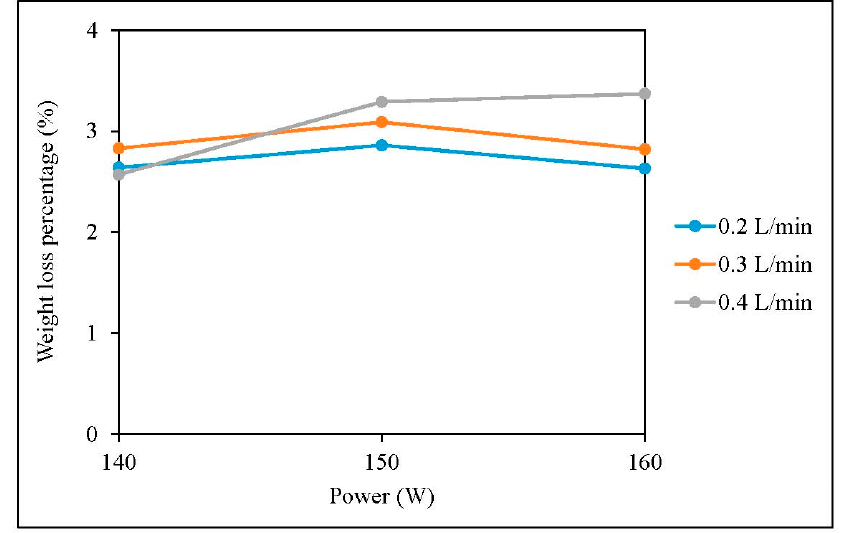
Figure 4. Weight-loss percentages of interlock fabric.